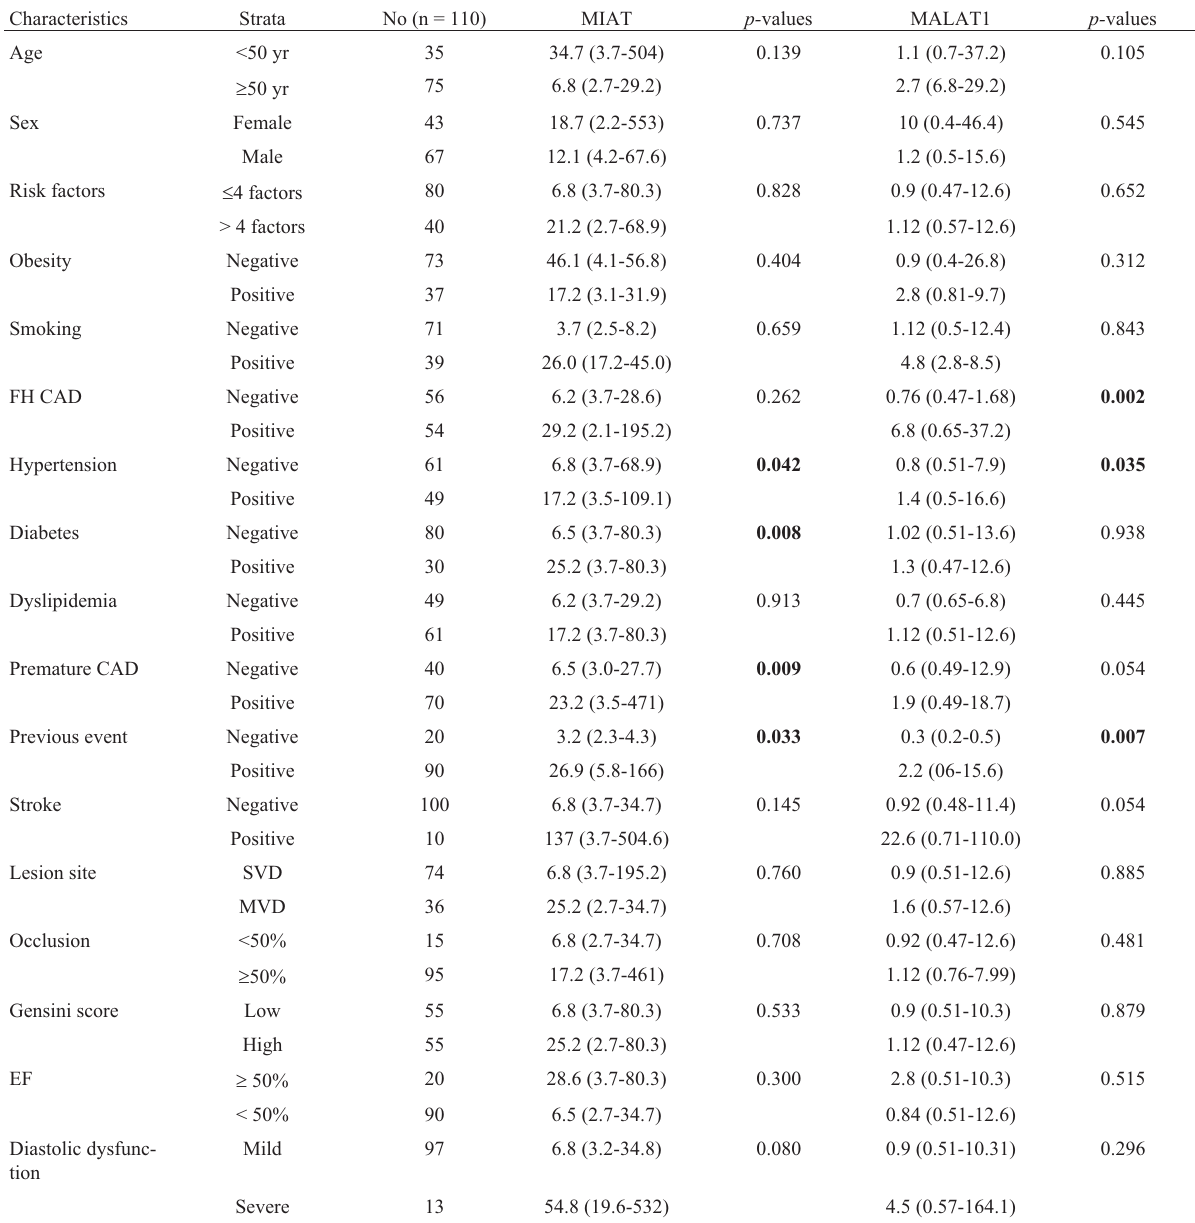
Table 2 - Association between MIAT and MALAT1 expression levels and clinical characteristics in patients.